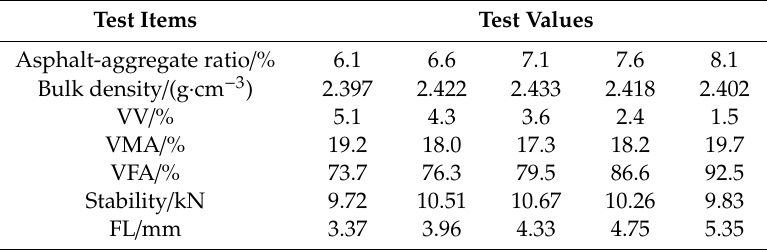
Table 8. Marshall test results of